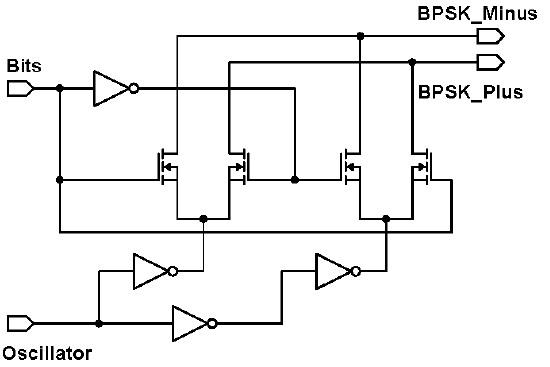
Figure 3. Circuit schematic of the binary phase shift keying (BPSK)